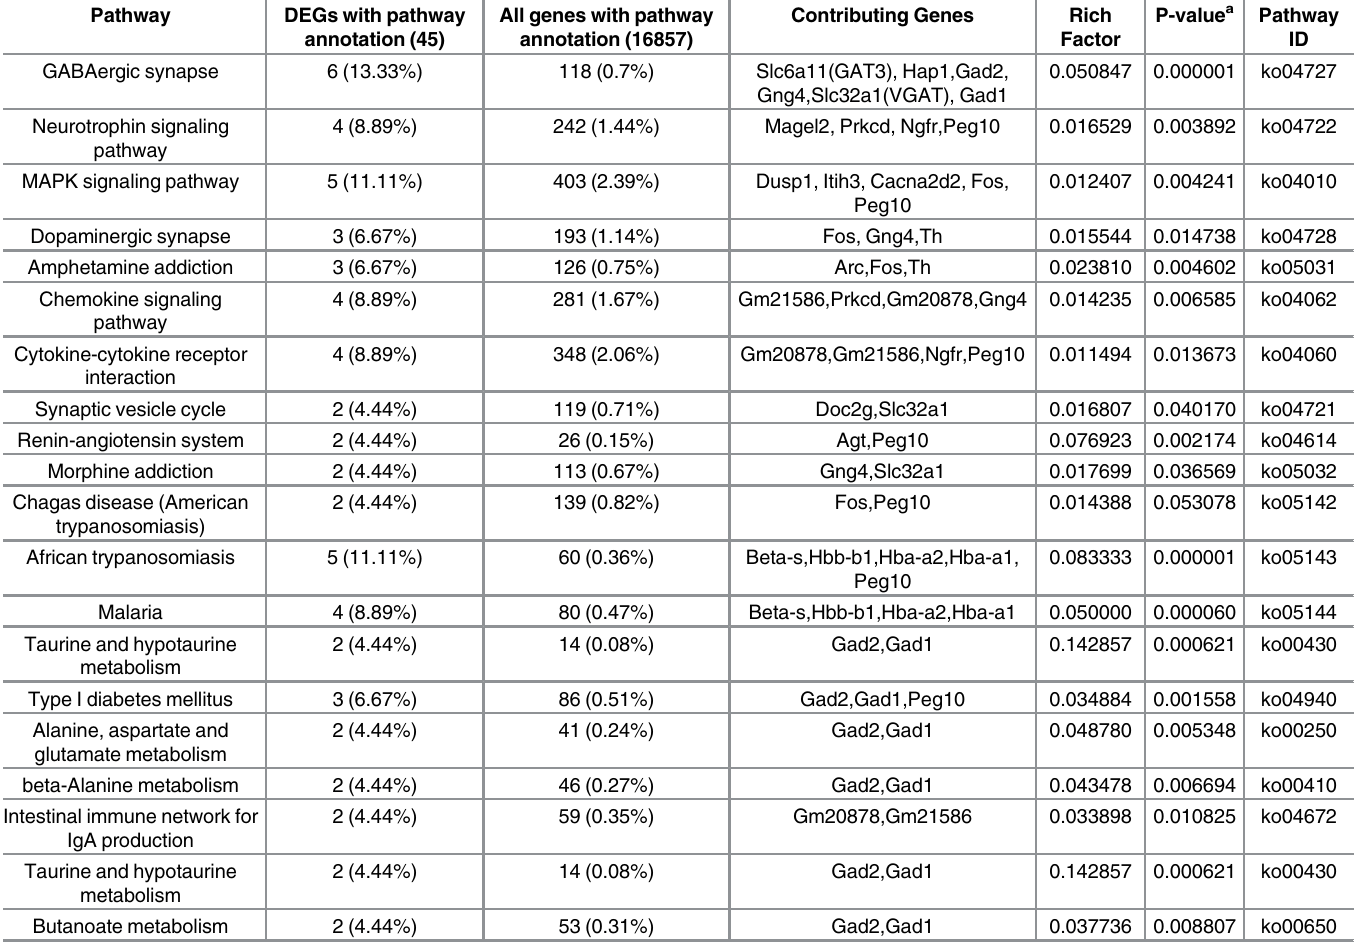
Table 2. Signaling pathways identified by KEGG function analysis based on DEGs